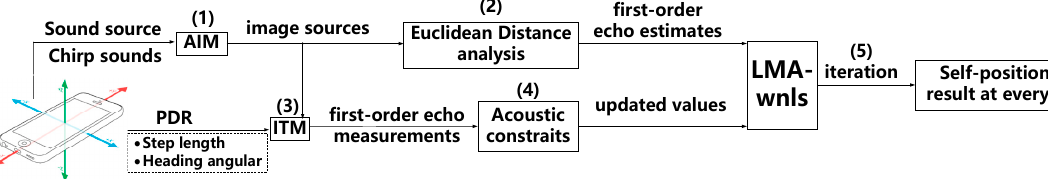
Figure 1. Overview of the proposed system architecture. AIM: Acoustic Image Model. ITM: Isosceles Trapezoid Model; LMA-WNLS: Levenberg–Marquardt algorithm-based weighted nonlinear least squares.